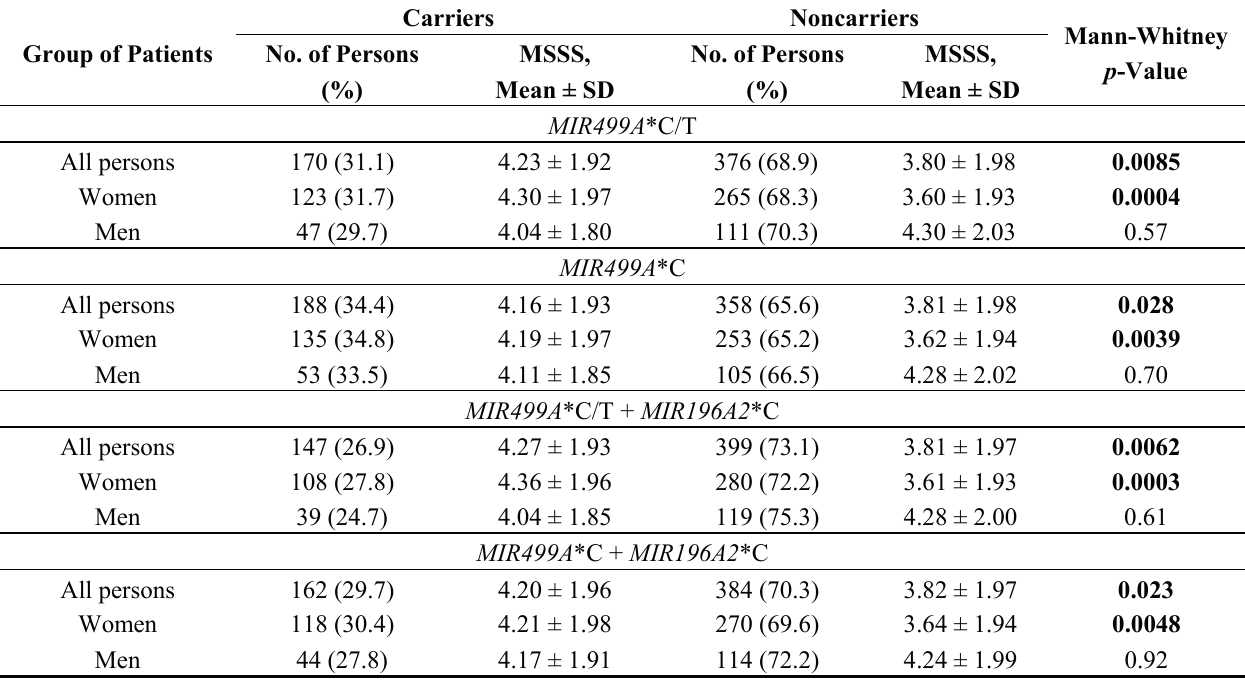
Table 4. Comparison of MSSS values between carriers and noncarriers of genetic variants associated with MS